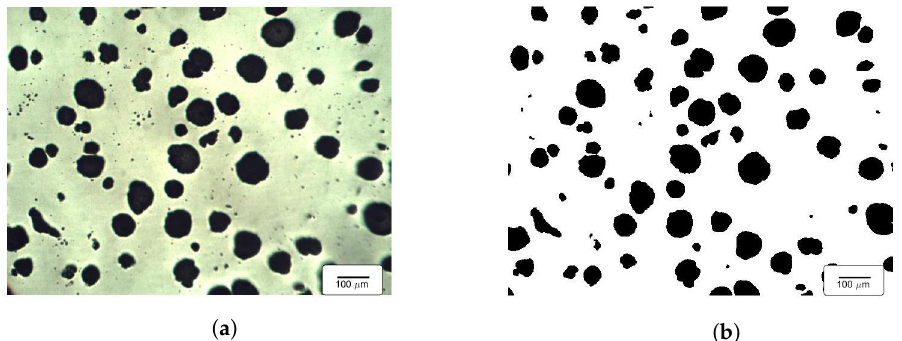
Figure 3. Sample microstructure image of nodular cast iron. 100 × magnification. ( a ) Input image. ( b ) Image